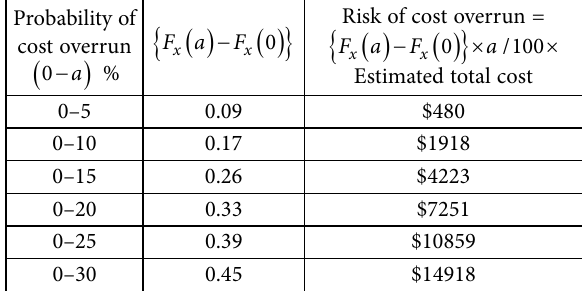
Table 3. Risk of time overrun for the case